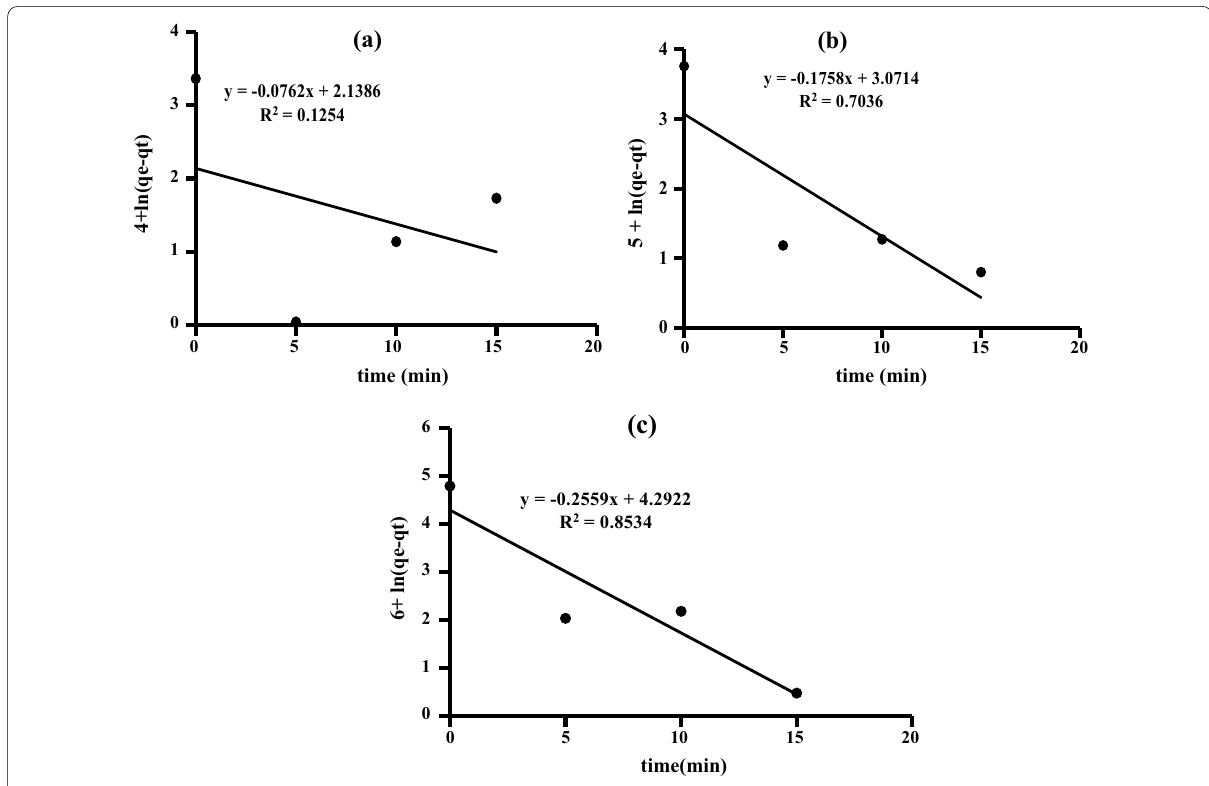
Fig. 13 First‑order module of copolymer ( a ), aniline graft ( b ) and 2‑chloroaniline graft ( c )